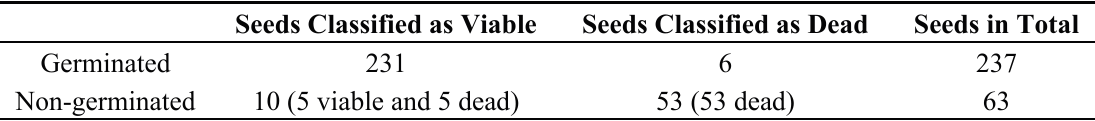
Figure 7. Mean reflectance spectra based on the reflection from the seed coat surface of seeds that germinate and non germinating seeds. Vertical bars represent standard deviation (in upper direction) from single seed replicates. Table 3. Data from the validation set. Number of seeds classified as viable and dead and germination results after six days of germination. The number in brackets shows the result after a tetrazolium test of the non-germinated seeds. The number of seeds classified as dead and viable in the prediction model, were based on an nCDA transformation employed in the Region MSI